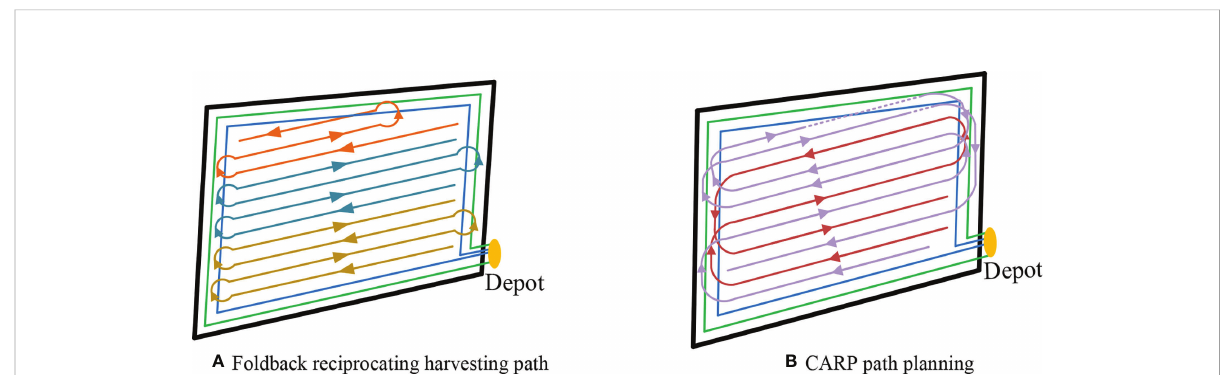
FIGURE 11 Path results underdifferent path planning methods within an irregular fi eld block (A) . Foldback (B) . CARP path planning reciprocating harvesting